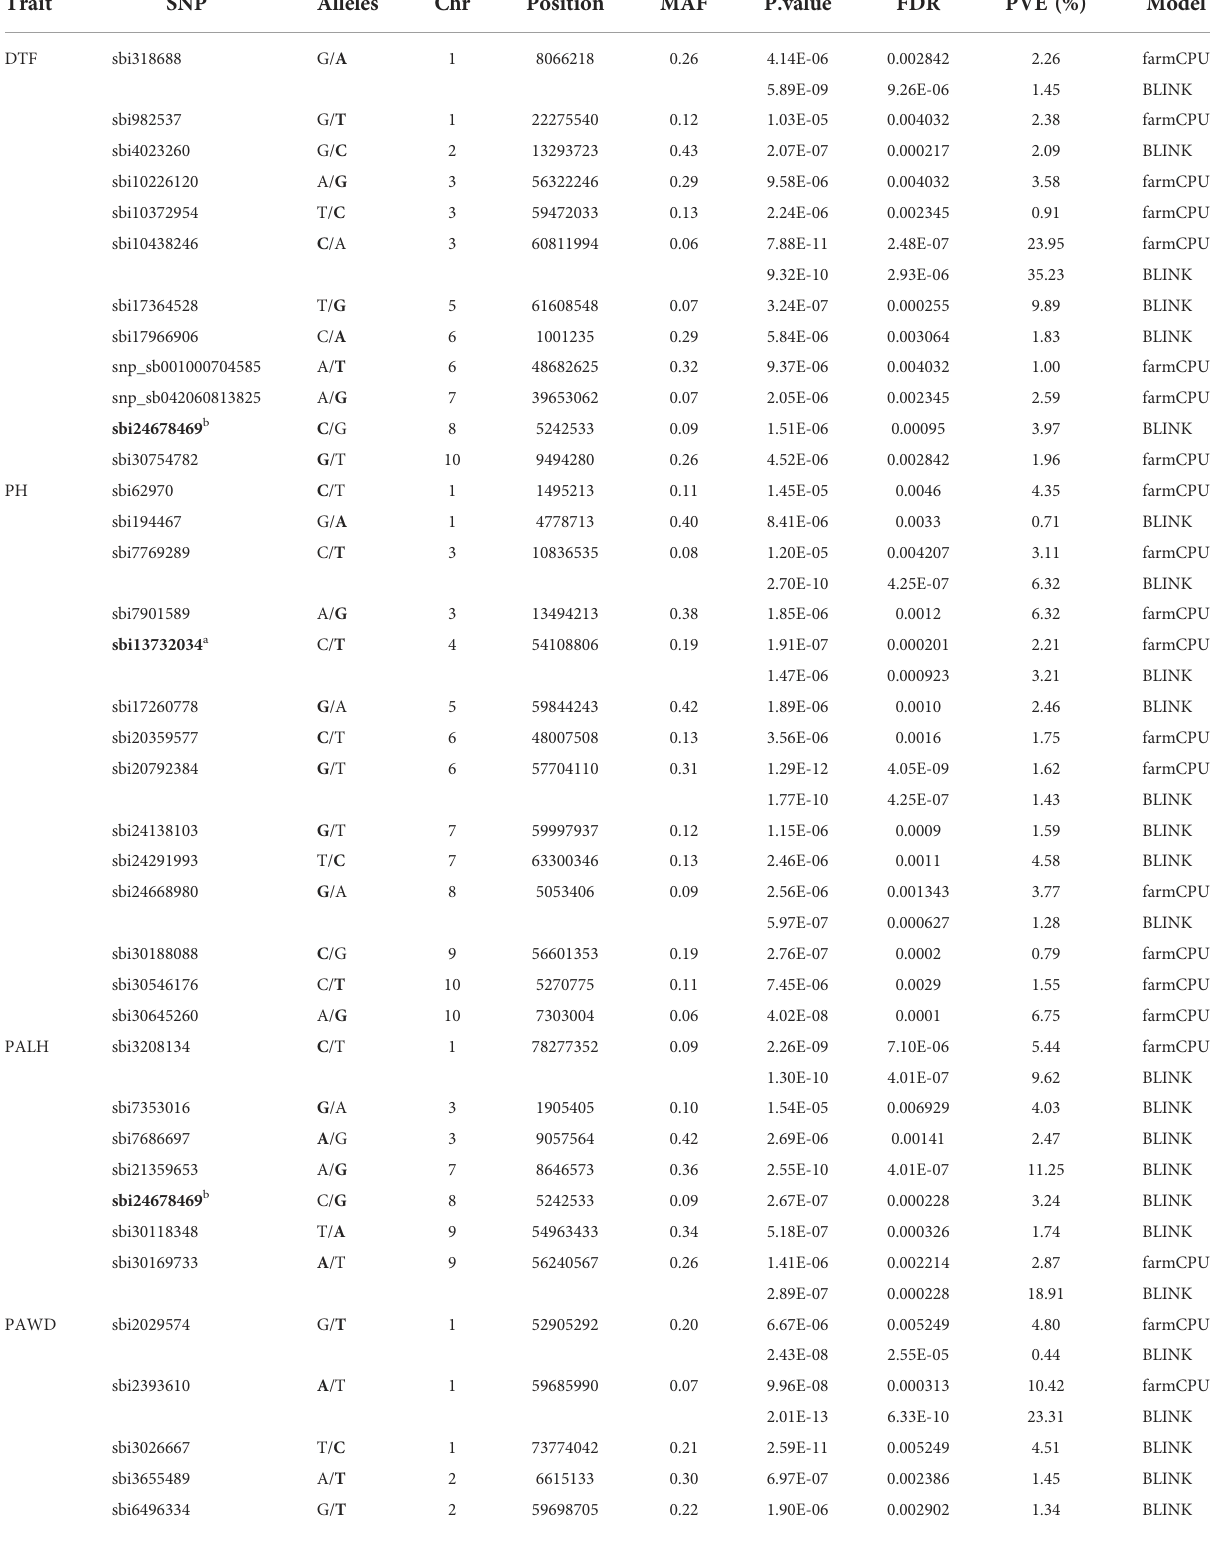
TABLE 3 List of signi fi cant markers associated with agronomic traits from genome-wide association analysis of 309 sorghum accessions using 3143 SNPs with MAF greater than 0.05.